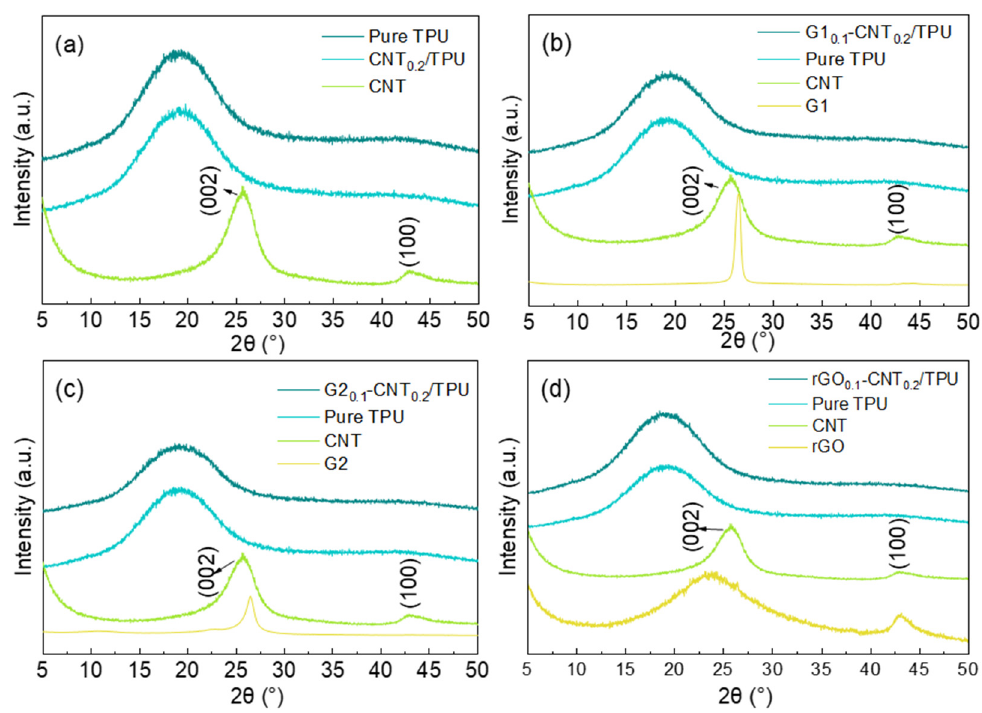
Figure 5. XRD patterns of pure PU film and PU composite films, with GN and CNT ( a ) CNT 0.2 /PU, ( b ) G1 0.1 - CNT 0.2 /PU, ( c ) G2 0.1 -CNT 0.2 /PU, and ( d ) rGO 0.1 -CNT 0.2 /PU.